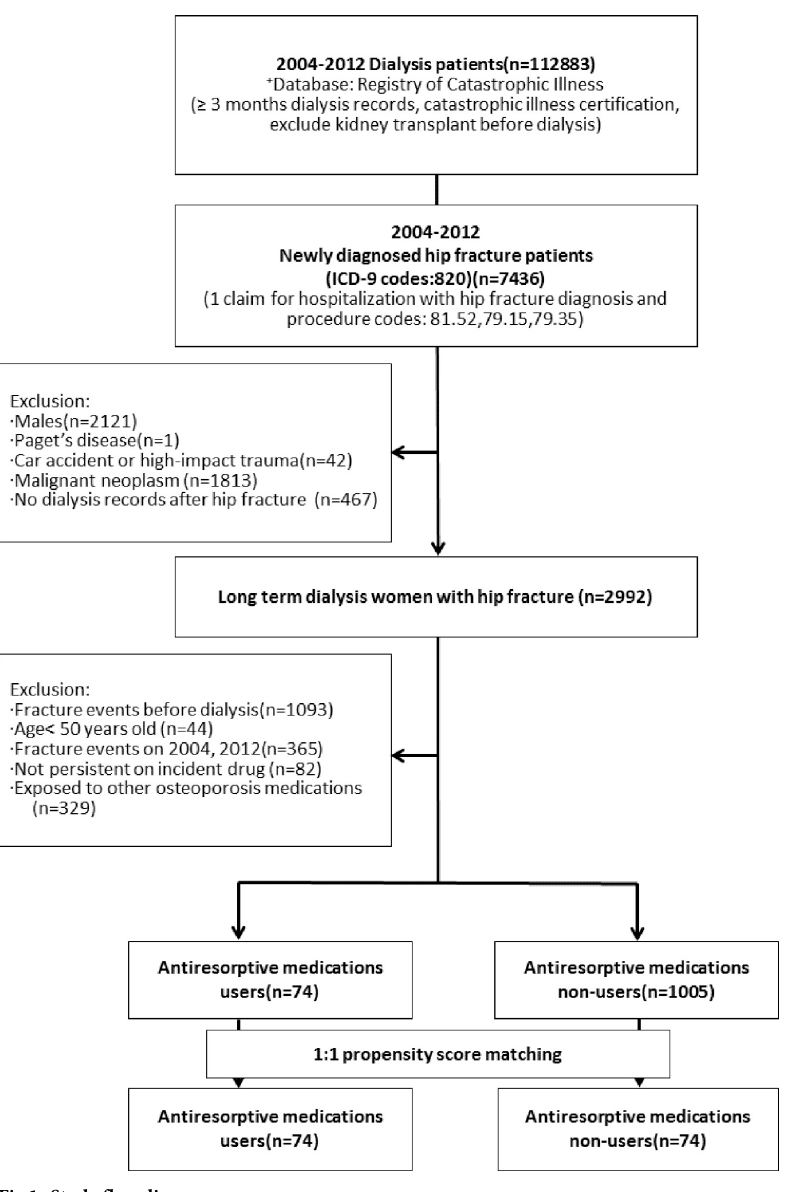
Fig 1. Study flow